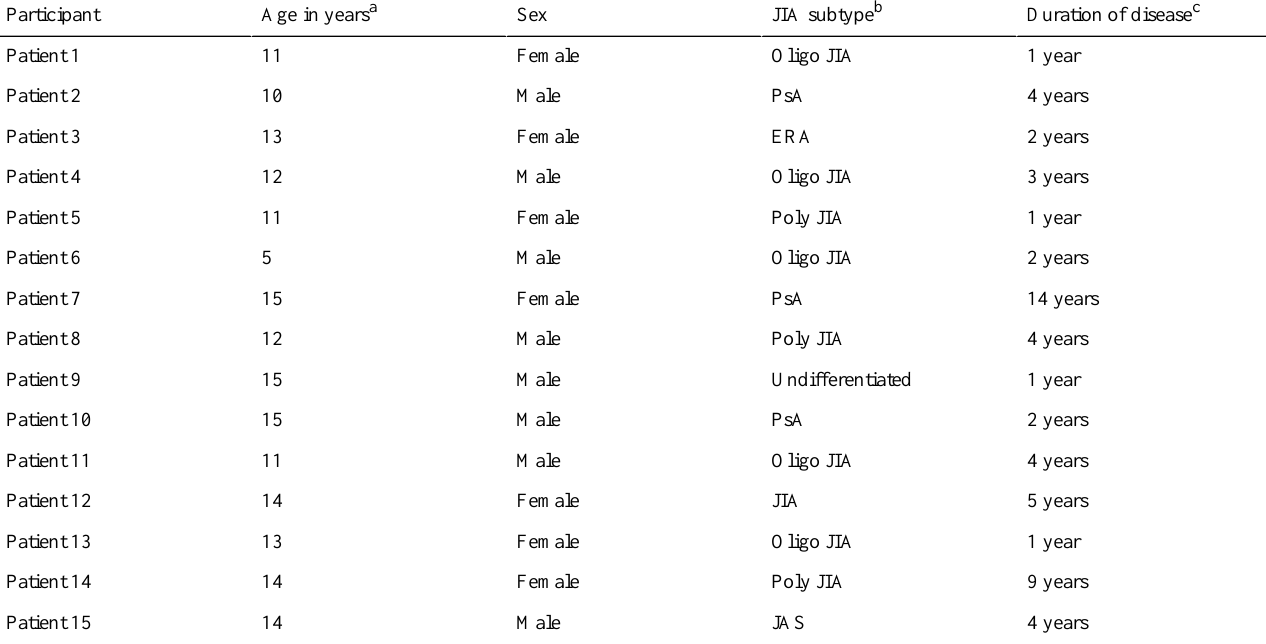
Table 1. Description of